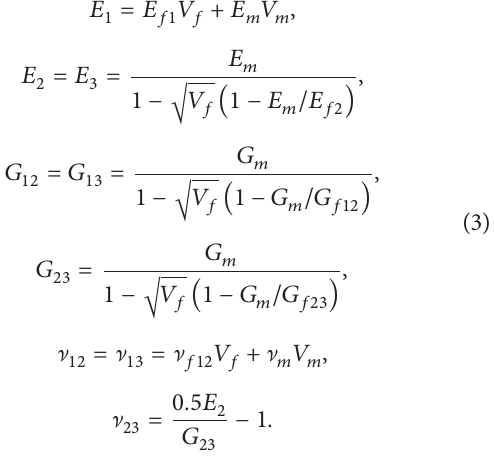
material parameters on weighing the sensitivity impact of the joint ultimate bearing